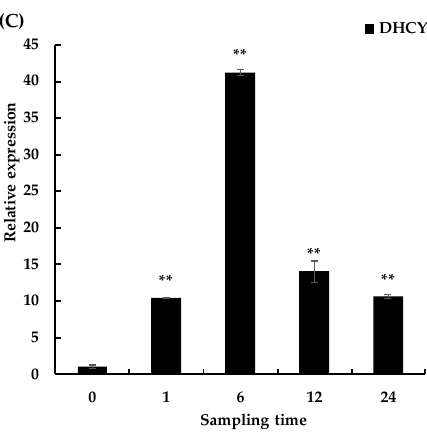
Figure 2. ( A ) Changes in DoBAM1 expression during tuber expansion. ( B ) Expression of DoBAM1 in different tissues of yam. ( C ) Expression levels in yam leaves during time course of cold stress. * and ** indicate a significant difference at p < 0.05 and p < 0.01, respectively.